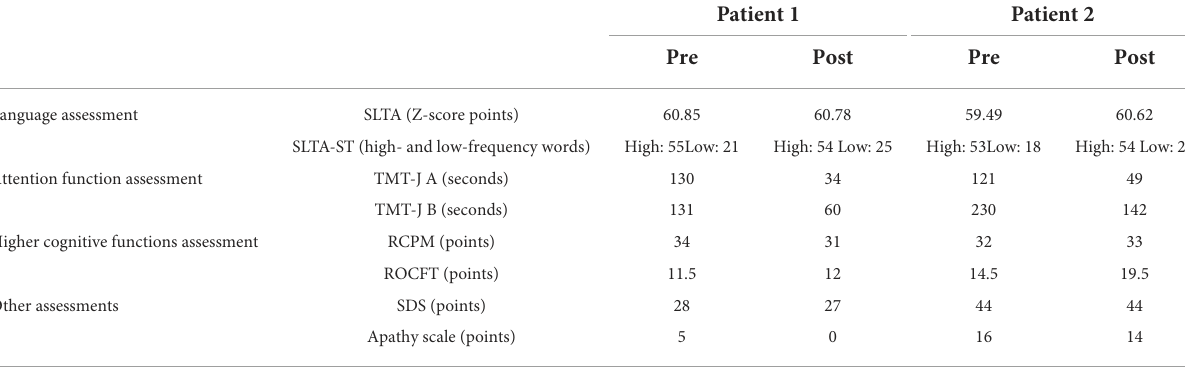
TABLE 1 Pre- and post-intervention results of language and attention function, higher cognitive functions